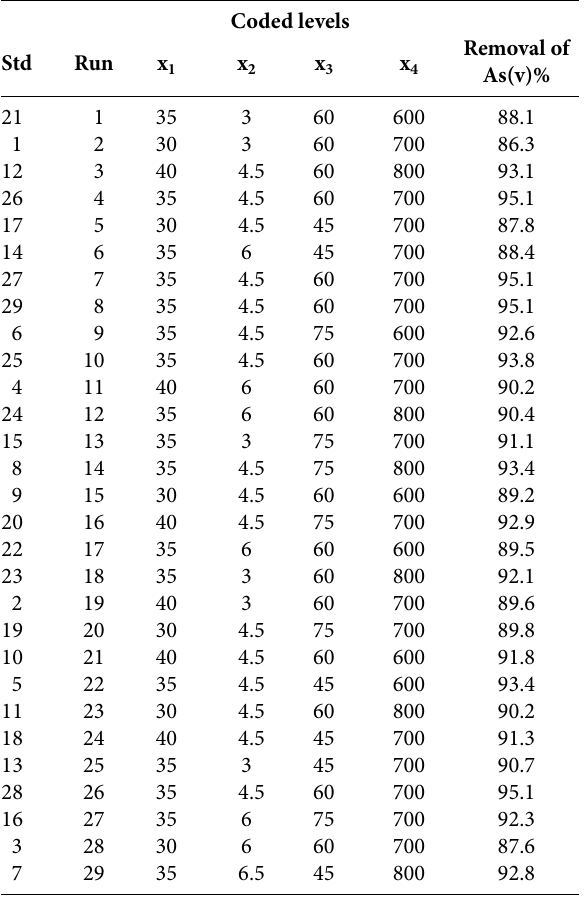
Table 2 . Experimental design of variables with adsorption results